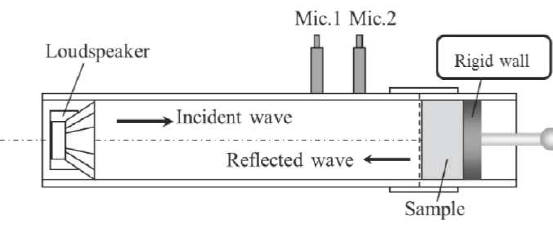
Figure 4. Instrumentation for the transfer function method of measuring sound absorption coefficients.